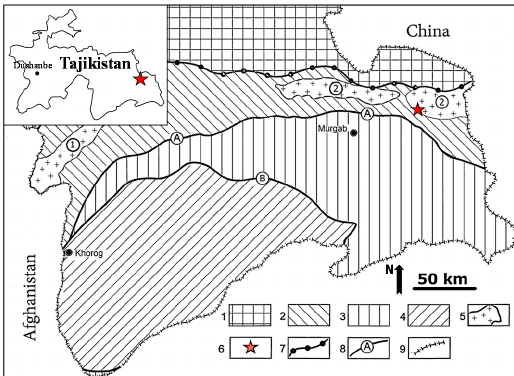
Figure 1. A location of the Snezhnoe deposit in relation to the main regional structures of the